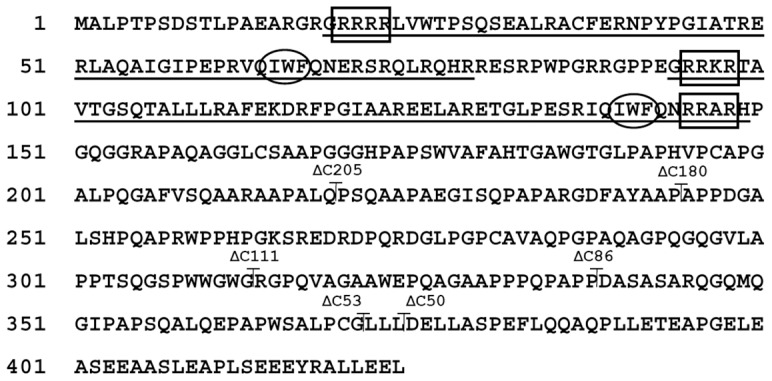
Conceptual DUX4 amino acid sequence.Homeodomains 1 (residues 19 to 79) and 2 (residues 94 to 149) are underlined. NLS1 (RRRR23), NLS2 (RRKR98) and NLS3 (RRAR148) are indicated (boxes). IWF1 (IWF65) and IWF2 (IWF140) are also indicated (ovals). The positions of the C-terminal amino acids remaining at the various C-terminal deletion mutants is shown.